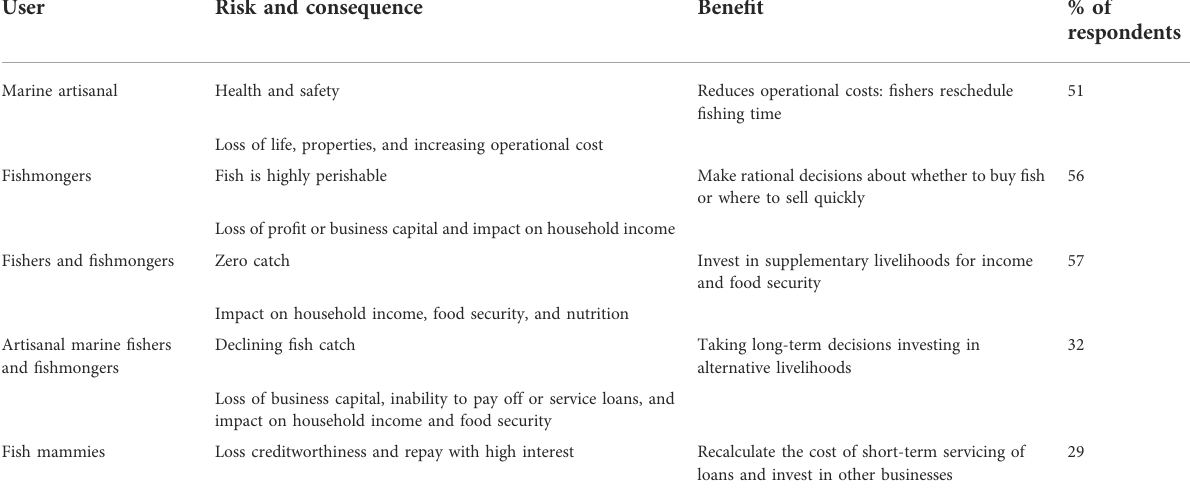
TABLE 2 Identi fi ed bene fi ts of WI to fi shers and those involved in secondary activities.